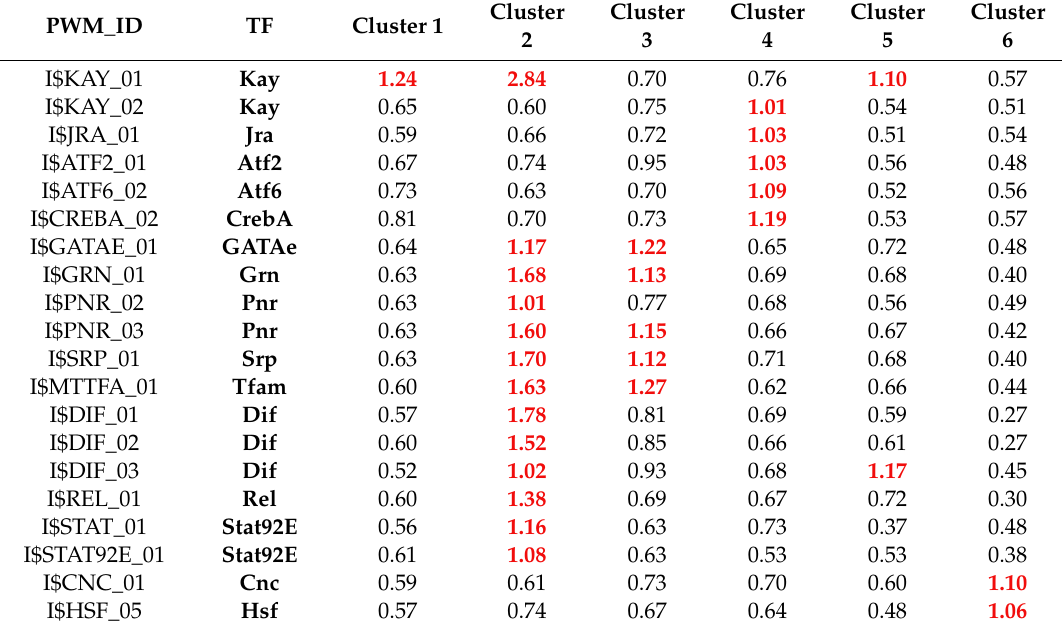
Table 4. TFBS enrichment analysis for promoter regions of co-expressed genes. Values presented: adjusted fold enrichment (statistically corrected odds ratios with a 99% confidence interval) for weight matrices of stress-associated transcription factors; significant enrichment is marked in